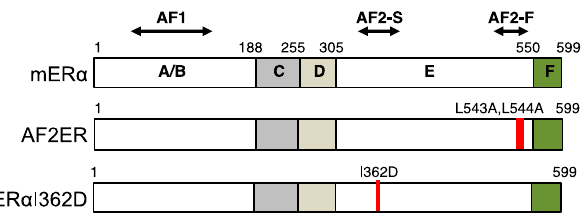
Figure 1. Schematic structure of mouse estrogen receptor α (mER α ). ER α consists of six domains named A to F. C-domain binds to an estrogen responsive DNA element. The ligands bind to E-domain (ligand binding domain; LBD). A/B-domain possesses the transactivation function 1 (AF1). E-domain possesses ligand-dependent transcription activation domain (i.e., AF-2). AF-2 is composed of static region (AF2-S) and flexible region (AF2-F). AF2-F corresponds to the helix 12 of LBD. The schematic structures of AF2-F mutant (AF2ER) and AF2-S mutant (mER α -I362D) are shown. Red bars indicate the position of mutated amino acids in the AF-2 mutants. The transcriptional activity of AF-2 corresponds to the ligand-dependent transformation of LBD.